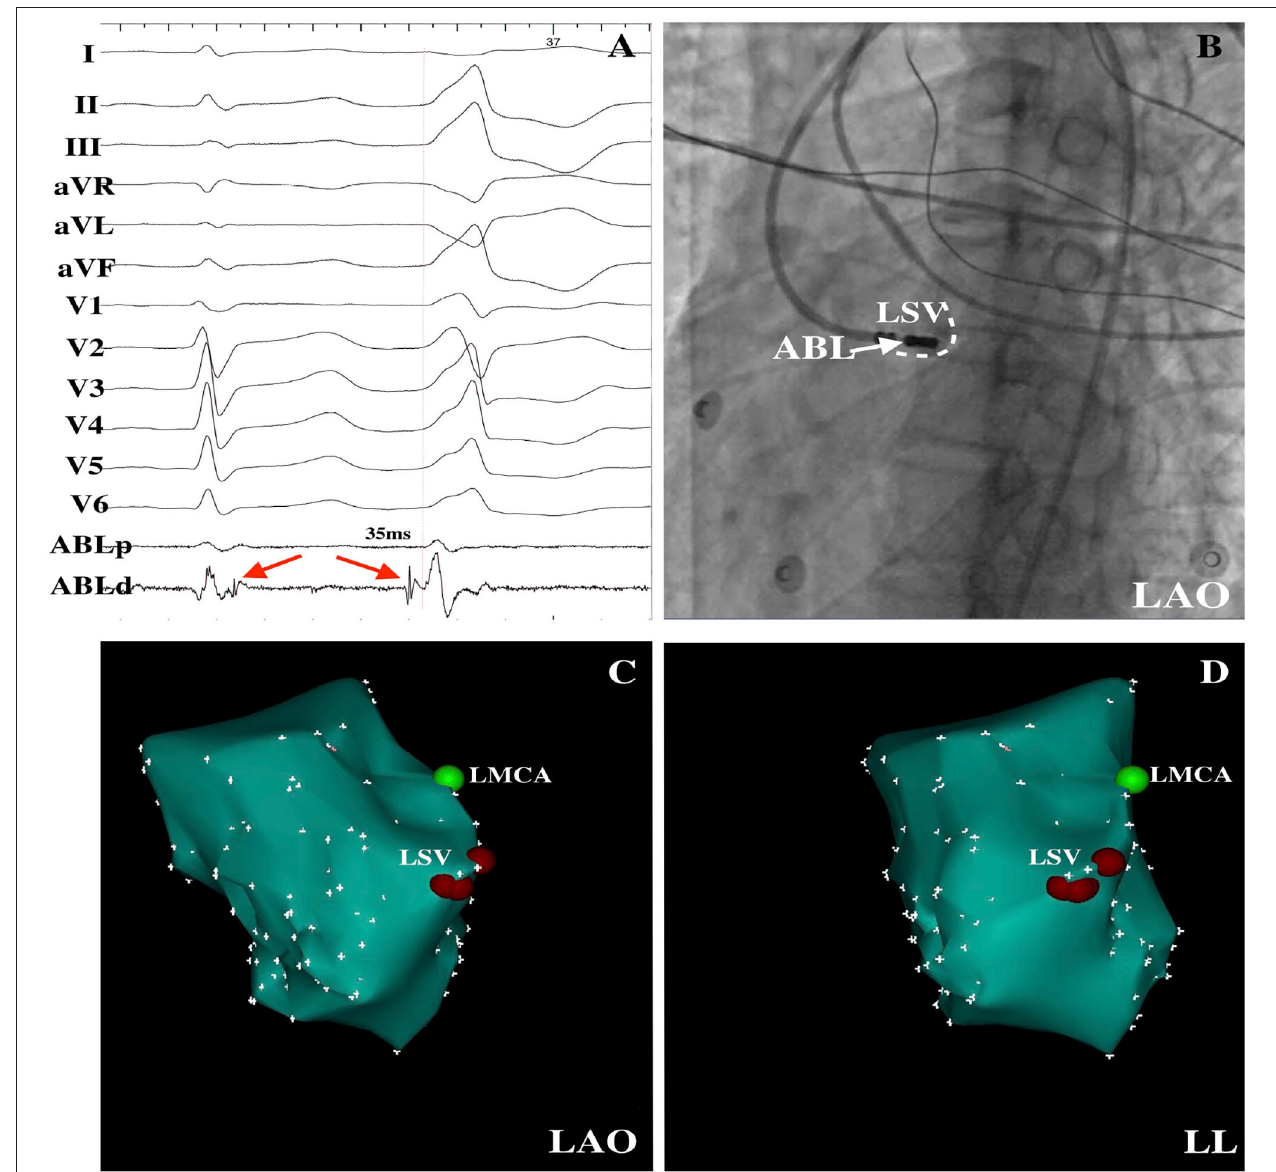
FIGURE 2 | PVCs were successfully ablated within the LSV. (A) Delayed potential (red arrow) was observed during the sinus rhythm, and a DPP on the LSV preceded the QRS by 35ms at the successful ablation site was recorded. (B) LAO radiographic view revealed the mapping catheter within the LSV. LAO (C) and LL (D) electroanatomical maps demonstrated the successful ablation points within the LSV. LSV, left sinus of Valsalva; DPP, discrete pre-potential; LAO, left anterior oblique; LL, left lateral; ABL, ablation catheter; LMCA, left main coronary artery.